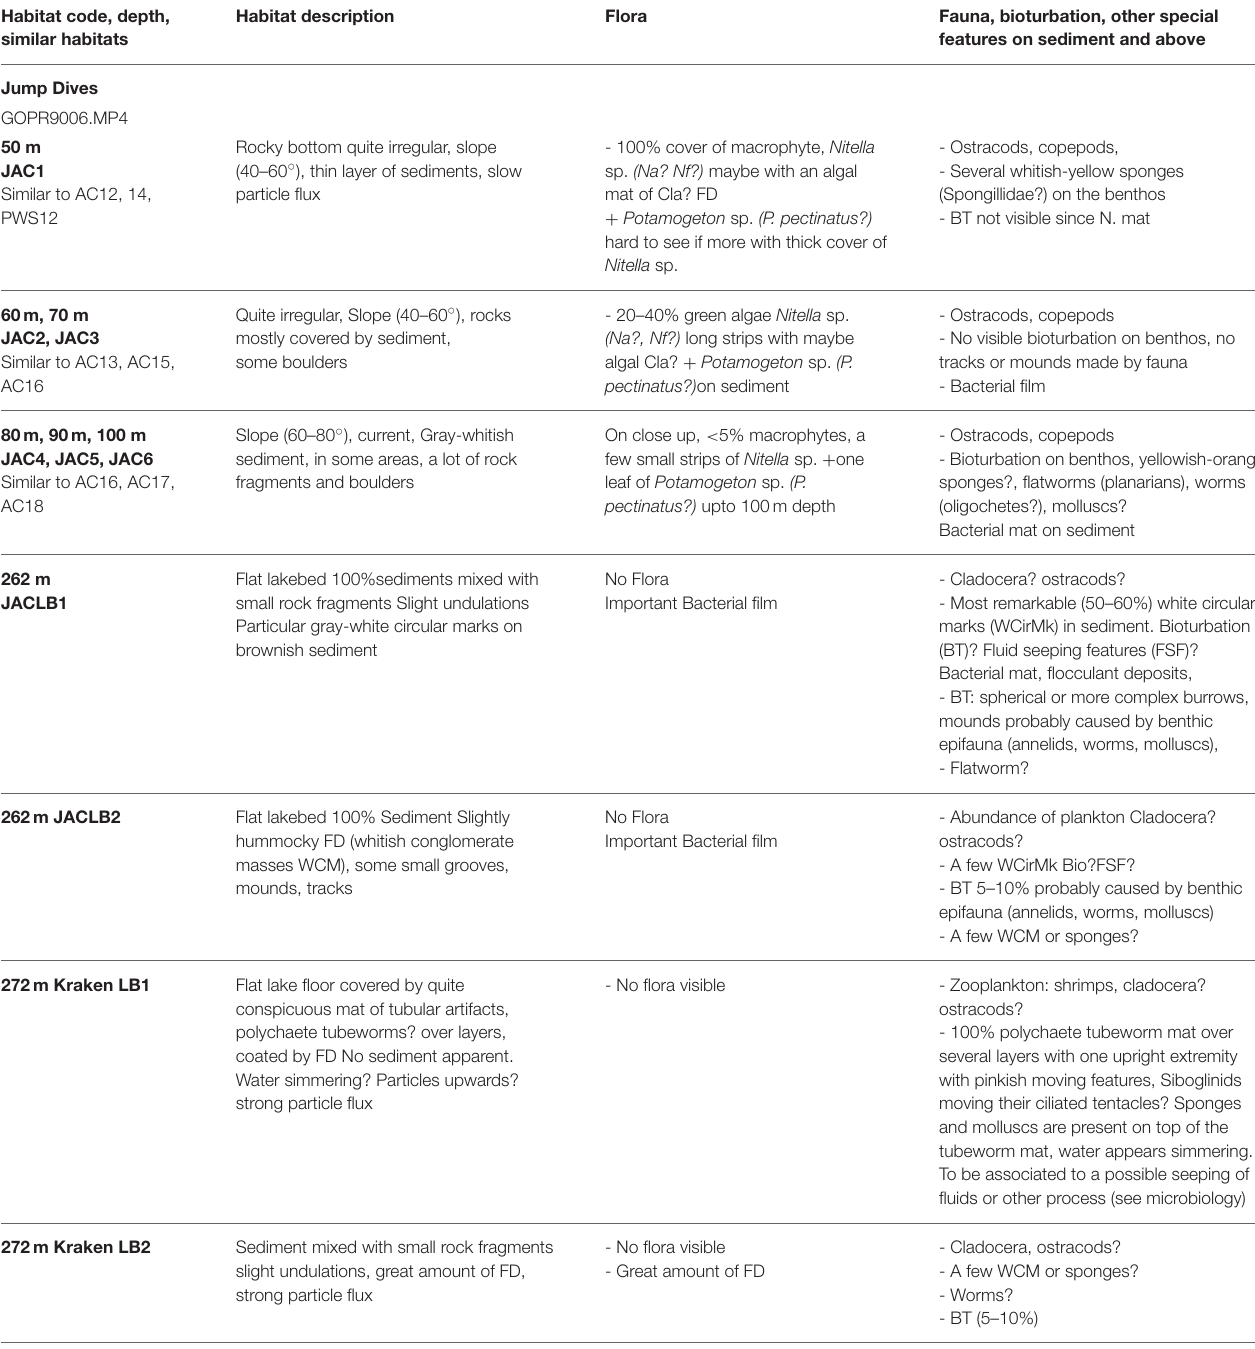
TABLE 4 | Summary of the main habitats and associated species of macrophytes and macrofauna observed on the videos taken during the jump dives. Habitat code, depth, Habitat description Flora Fauna, bioturbation, other special similar habitats